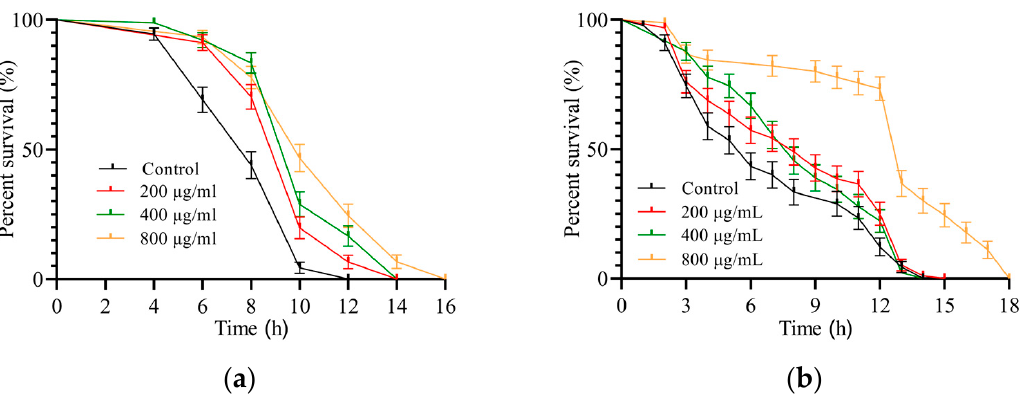
Figure 3. The black curve is the control group and the colored curves are the SH-treated groups. The colored curves in both graphs are shifted to the right, indicating that SH prolongs the lifespan of nematodes under stressful conditions. ( a ) is the survival curve of nematodes under heat shock and ( b ) is the survival curve under H 2 O 2 oxidative stress. Each stress experiment was conducted three times.